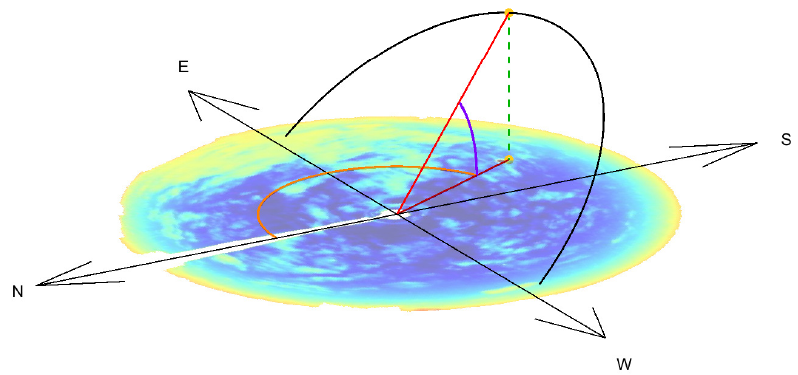
Figure 8. Representation of solar angles used: azimuth is shown by the orange line, while the elevation is shown with the purple one.